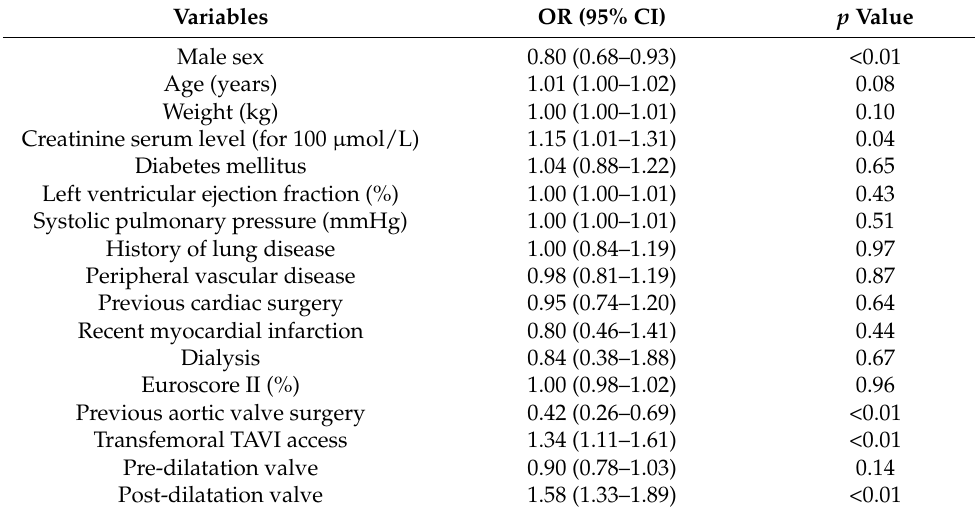
Table 3. Multivariate analysis of a 30-day permanent pacemaker (PM) implantation after transcatheter aortic valve implantation